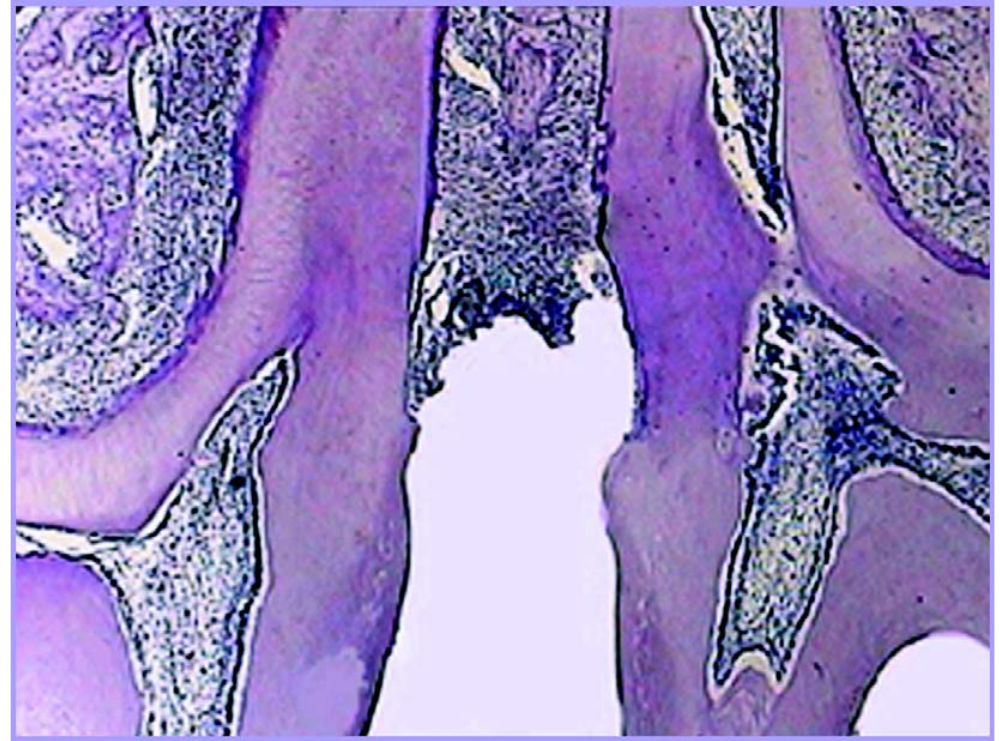
FIGURE 3- Figure illustrating the group with ligature-induced